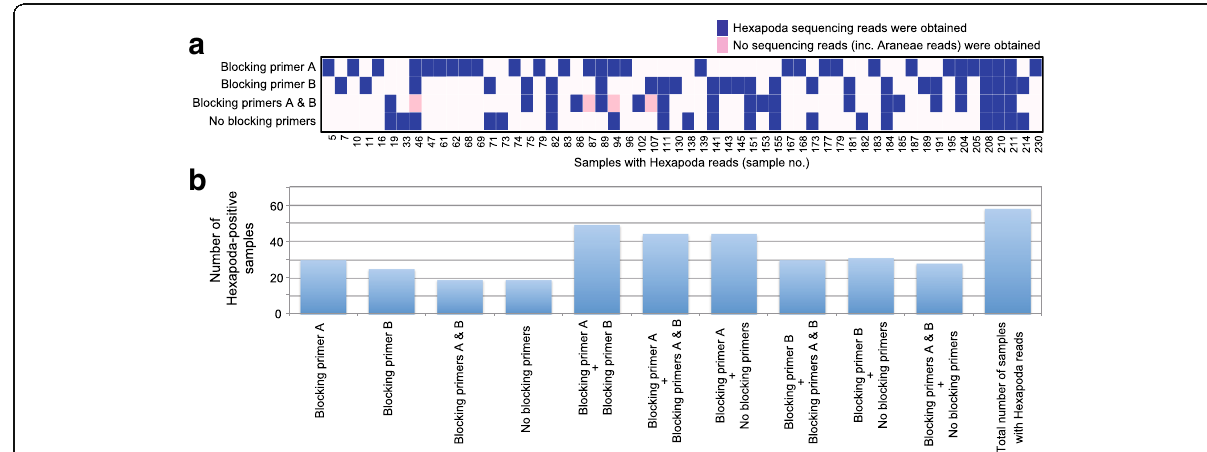
Fig. 2 PCR settings and number of Hexapoda-positive samples. a Consistency/inconsistency in the detection of Hexapoda reads among the four PCR settings. The 58 samples from which Hexapoda reads were obtained in any of the four settings are shown. b Comparison of the number of Hexapoda-positive samples. In addition to the results from each single PCR condition, those based on the combination of two PCR settings are